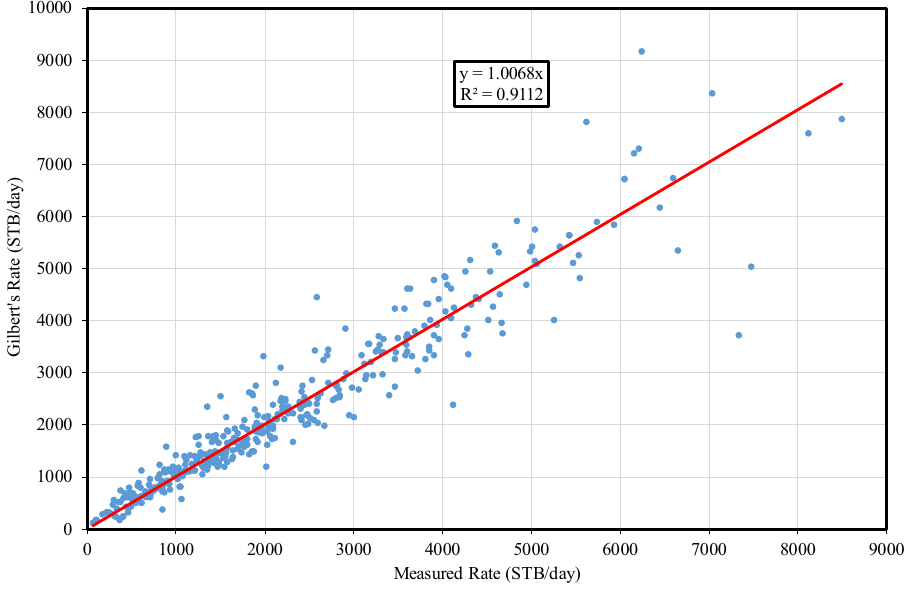
y = 1.0068x R² = 0.9112